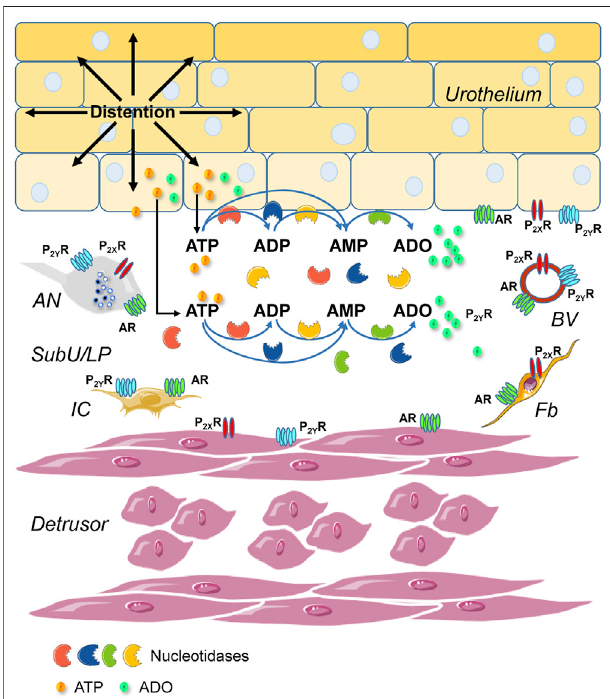
FIGURE 12 | A model depicting mechanisms of purinergic signaling in the lamina propria during bladder fi lling. Stretch of the bladder wall during fi lling causes release of ATP from the urothelium into the suburothelium (Birder and Andersson, 2013; Burnstock, 2014; Dalghi et al., 2020). ATP